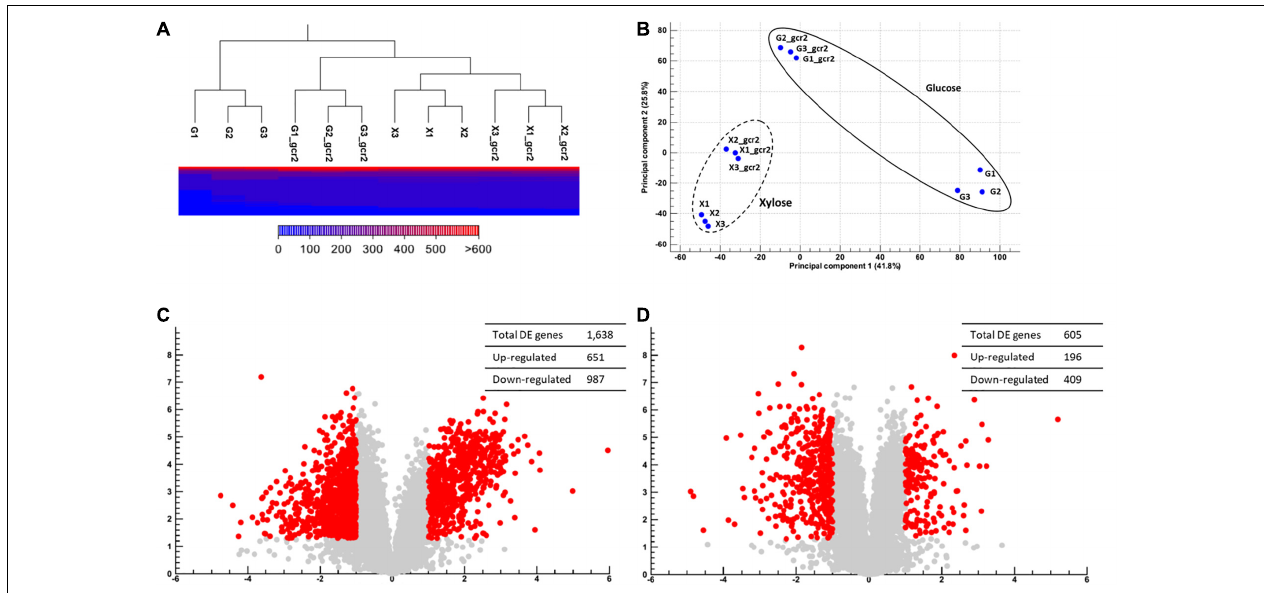
FIGURE 2 | Global transcriptional changes induced by (cid:49) gcr2. Hierarchical clustering and multivariate analysis based on Pearson’s correlation (A) and principal component analysis (B) . DE genes ( p < 0.05, > 2-fold) on glucose (C) and on xylose (D) were identified. RNA samples were extracted from exponentially growing SR7 and SR7 (cid:49) gcr2 strains on glucose and xylose.